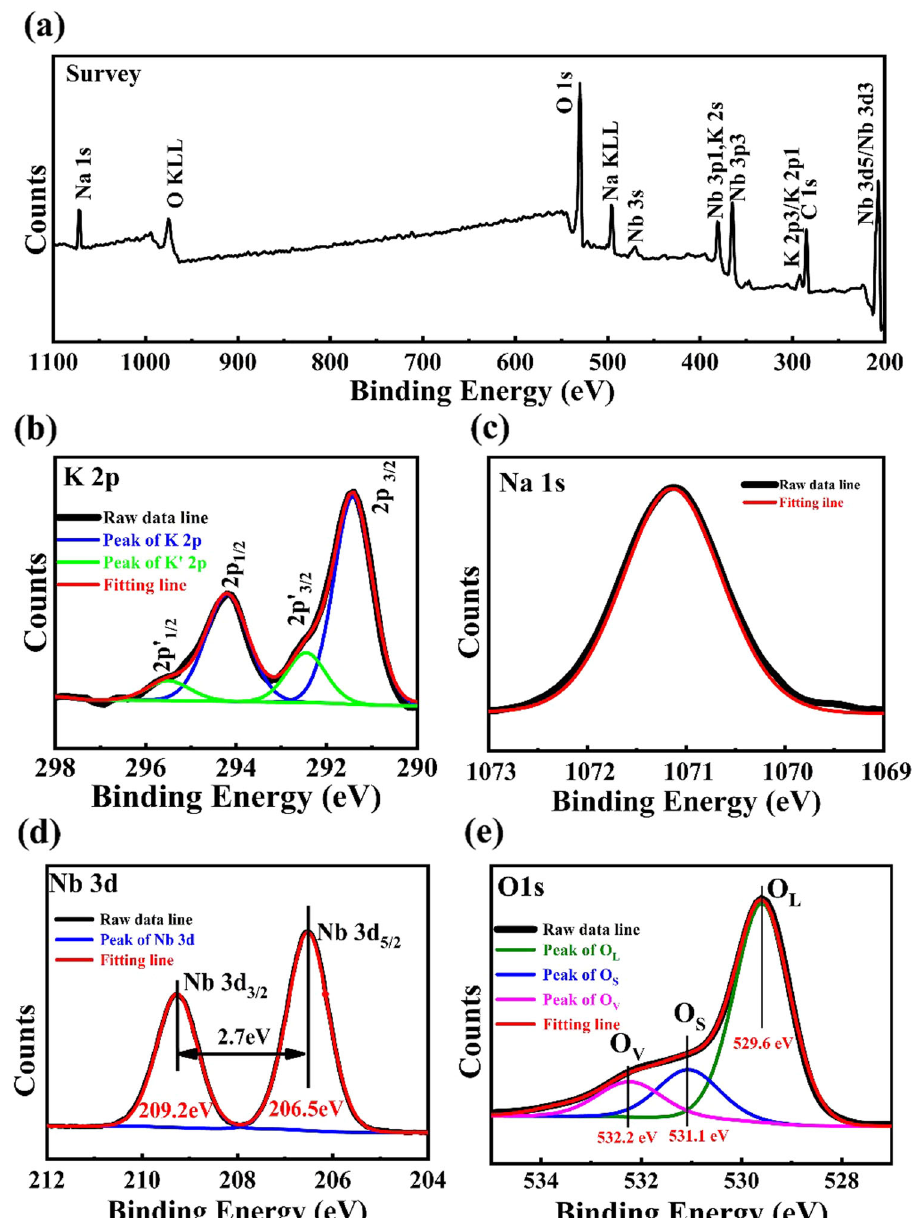
Fig. 5 Chemical properties of the KNN fi lms. a survey spectrum and (b – e) narrow-scan spectra of (b ) K 2p, c Na 1s, d Nb 3d, and (e ) O 1s core levels from the 150 nm KNN fi